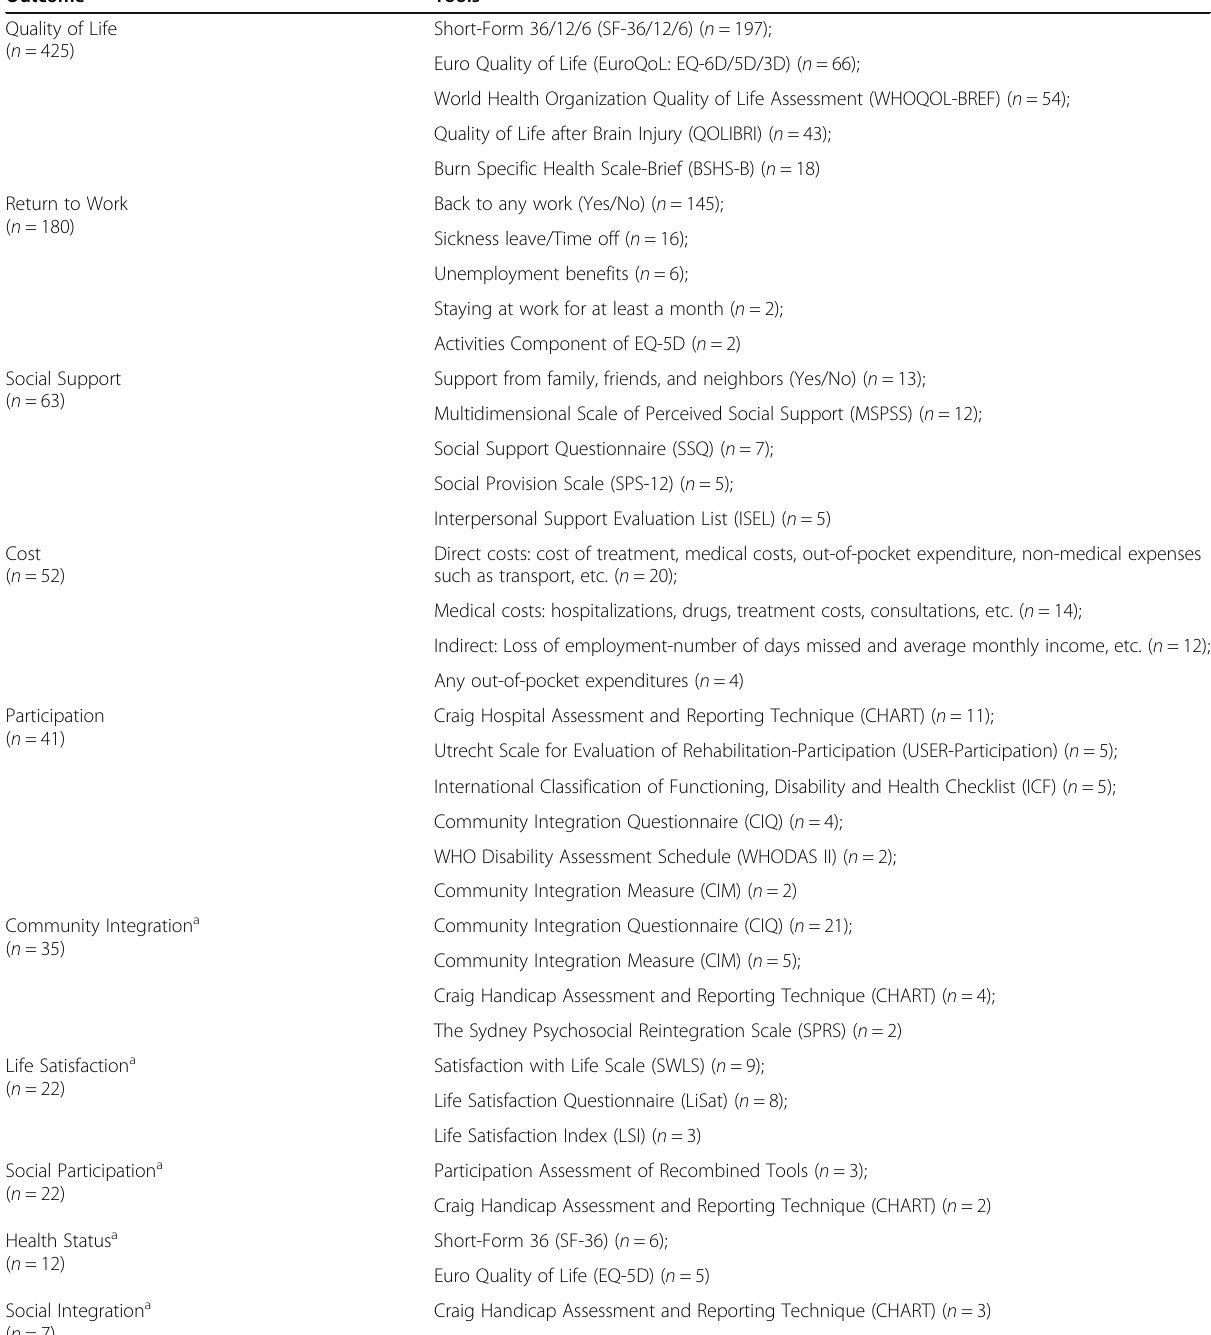
Table 4 Most Reported Outcomes and the most used Outcome Tools for the outcomes Outcome